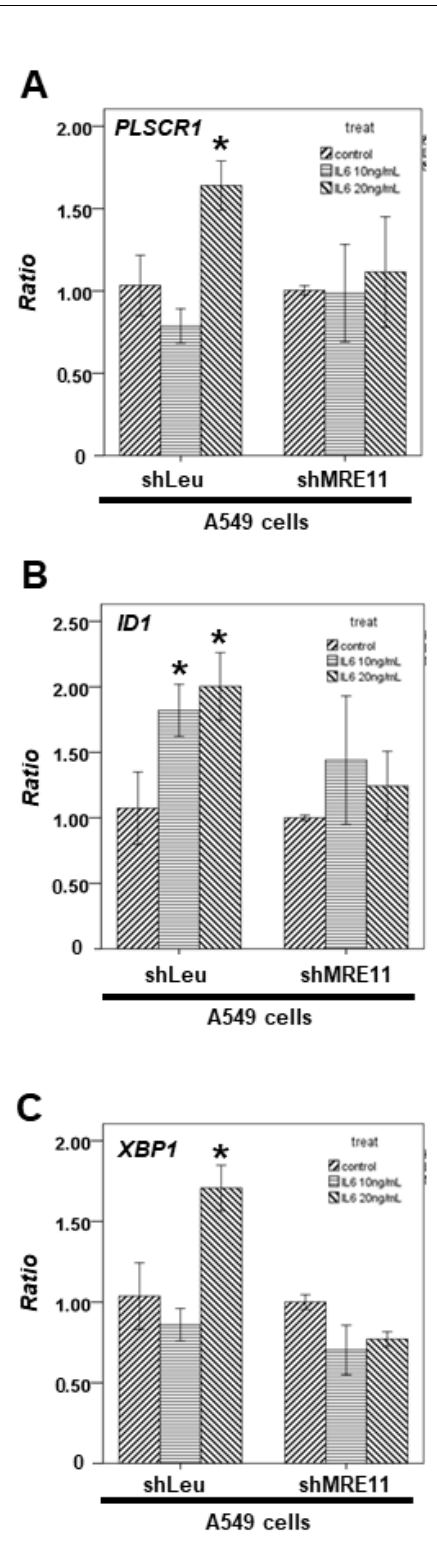
Figure 2. The effect of MRE11 on STAT3 ′ s downstream genes treated with IL-6. Total mRNA was extracted from the A549 shLeu and A549 shMRE11 cells after treatment without or with IL-6 for 24 h. The coding regions of human PLSCR1 ( A ), ID1 ( B ), and XBP1 ( C ) were used as probes for real- time polymerase chain reaction analysis. (Error bars = mean ± S.E.M. Asterisks (*) mark samples significantly different from the DMSO group with p < 0.05.).